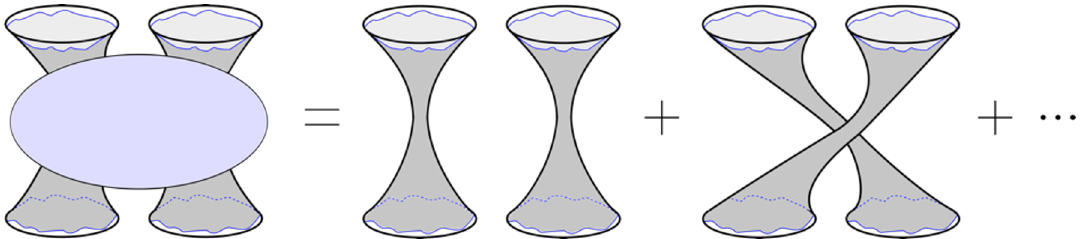
Figure 1 . The transition amplitude h ‘ 1 , ‘ 2 | b U | ‘ 0 , ‘ 0 i is a sum over geometries which connect two 1 2 circles at past infinity with two circles at future infinity. At leading order in the genus expansion, the amplitude is a sum of two terms, analogous to Wick contractions, as given in eq. (2.11). The dots indicate subleading terms in the genus expansion. Each boundary circle is “wiggly,” on account of the Schwarzian reparameterization mode living on